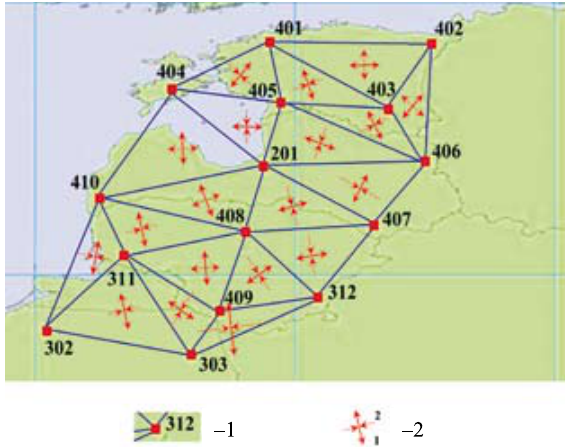
Fig. 1. GPS network and orientation of the horizontal principal strain axis: 1 – GPS benchmark, 2 – principal strain direction (1 – maximum principal strain (extension), 2 – minimum principal strain